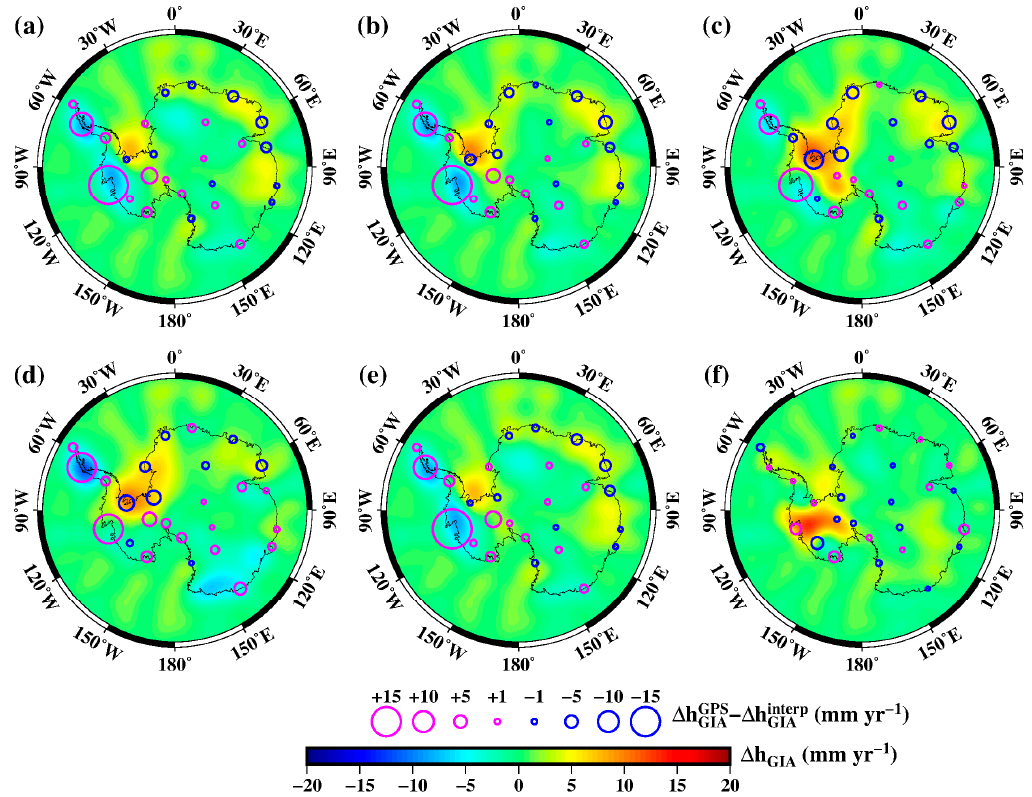
Figure 3. Estimated GIA uplift rates from the JIE method using the suggested ETM models from